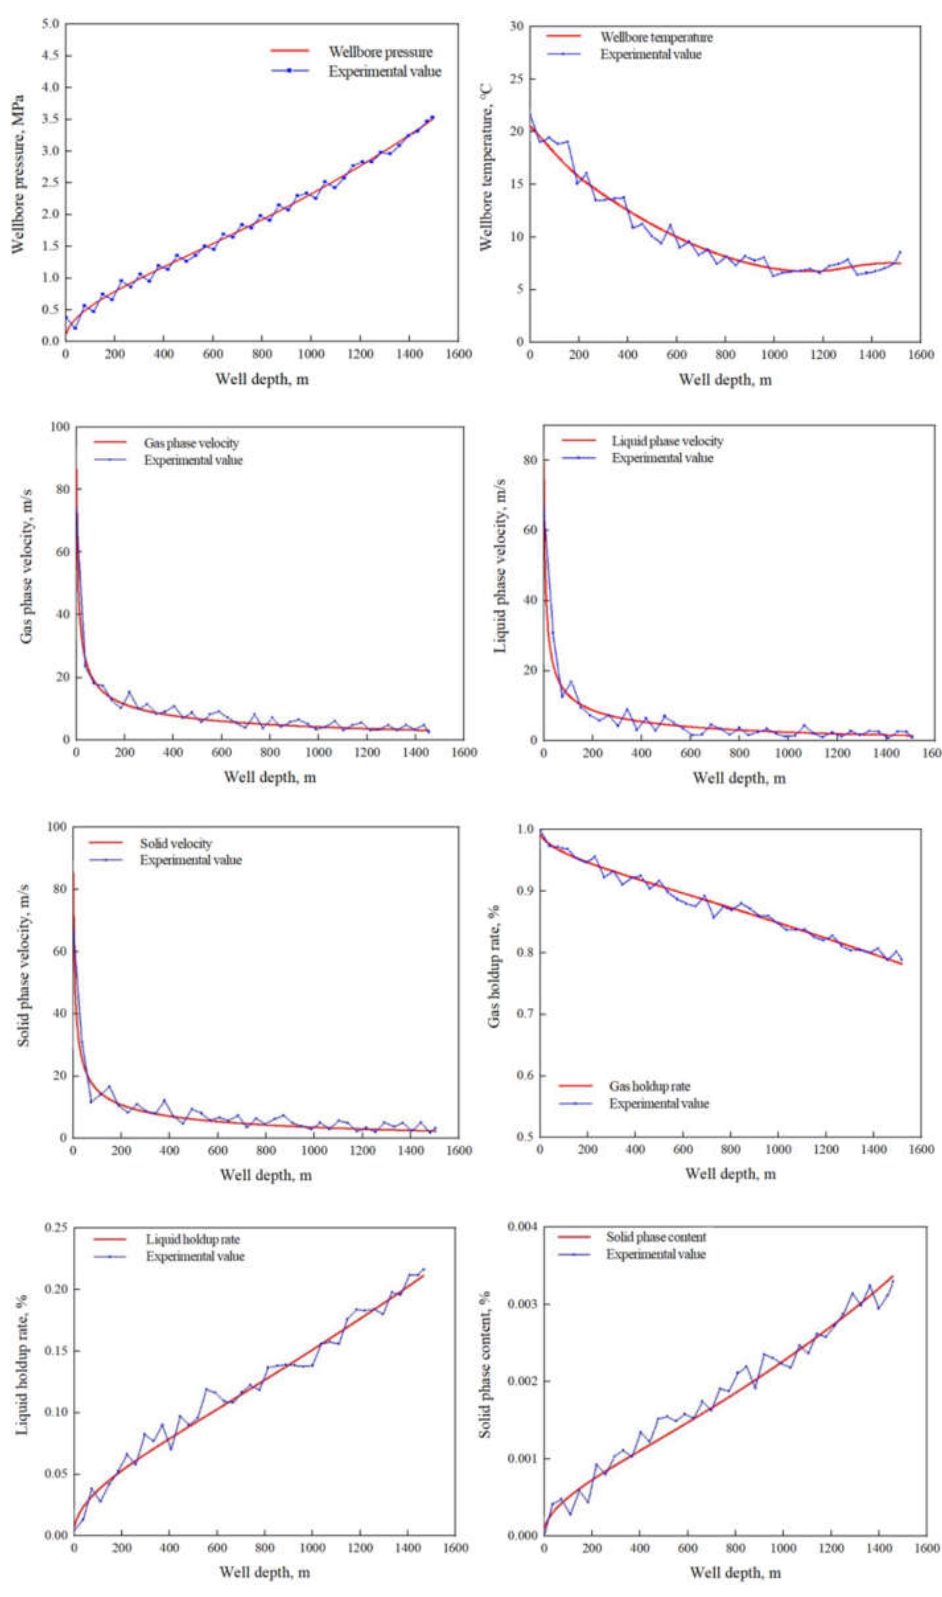
Figure 13. Comparison curve between theoretical and experimental values of wellbore rheological